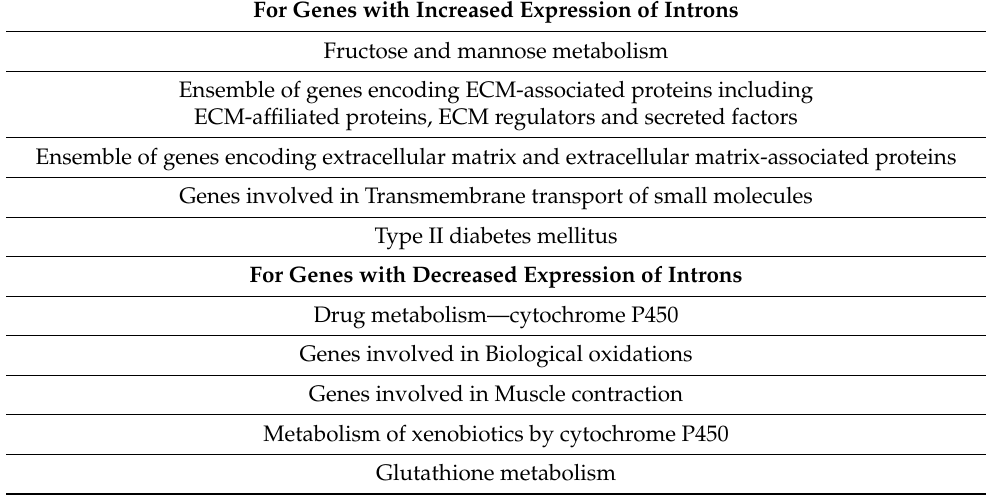
Vitamin E supplement: Table 3 shows the list of 44 genes with increased intronic RNA expression after Vitamin E supplement treatment that overlapped with the gene-expression signature of